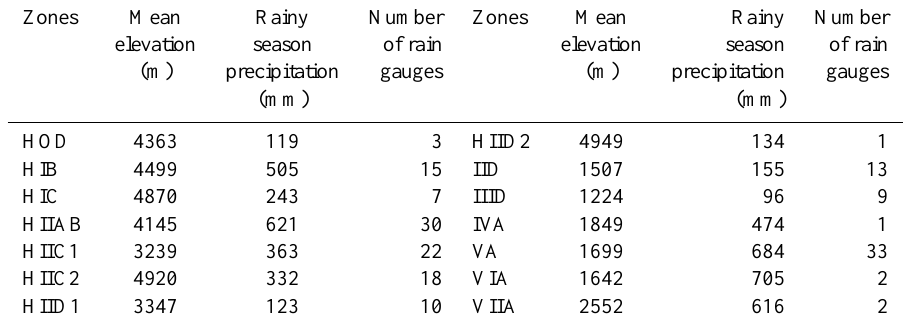
Table 2. Characteristics of the climate zones. Meanings of the zone names are referred to Fig. 2. The rainy season precipitation here refers to six months from May to October and is calculated as the median of TMPA, CMORPH and PERSIANN estimates. Zones Mean Rainy Number Zones Mean Rainy Number elevation season of rain elevation season of rain (m) precipitation gauges (m) precipitation gauges (mm) (mm) HOD 4363 119